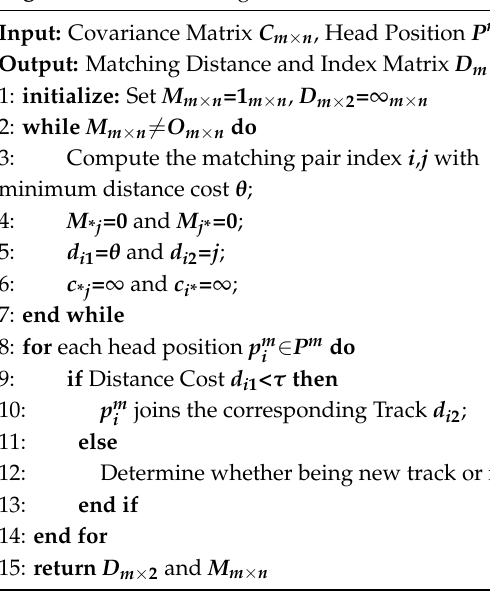
Figure 6. The procedure of computing elements in the covariance matrix C and mask M . Algorithm 1. Track Assignment